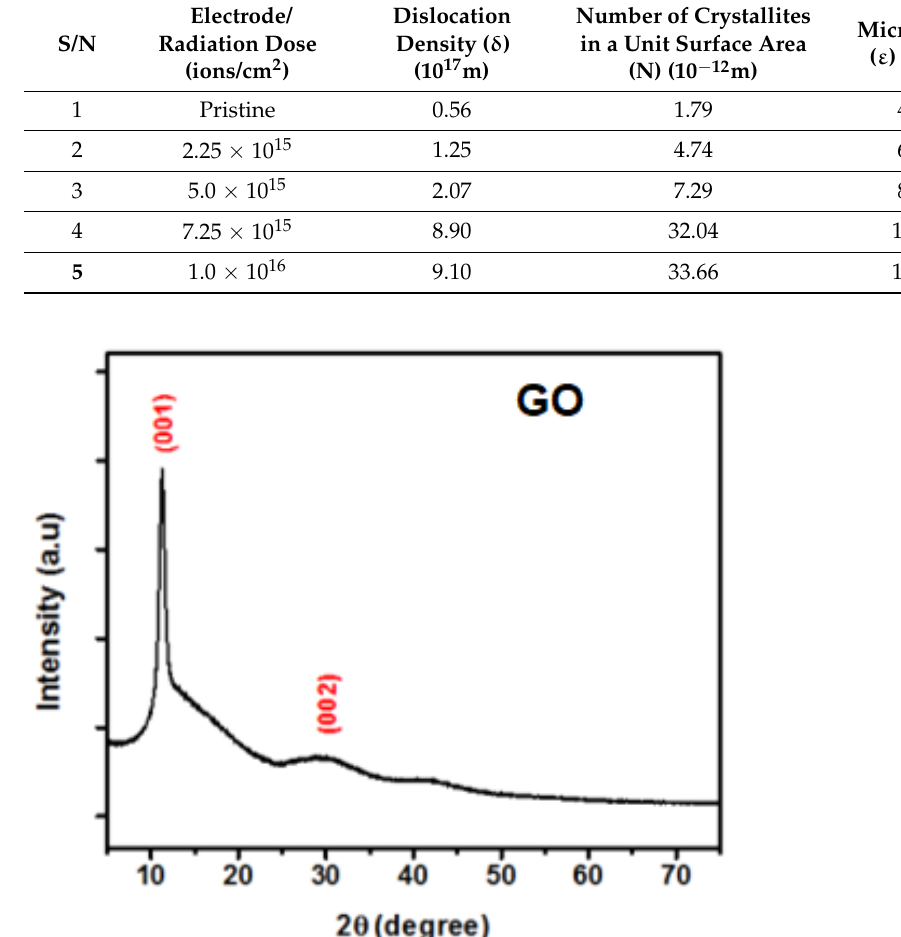
Figure 2. XRD spectra of hydrothermally synthesized Figure 2. (a) XRD spectra of hydrothermally synthesized GO